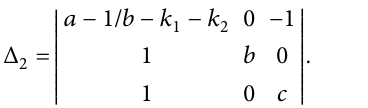
Figure 2: The phase diagram (a) and the time series diagram (b) of system (3a)–(3c) with initial value ( 0 . 1 , 2 , 0 . 1 ) for τ � τ 2